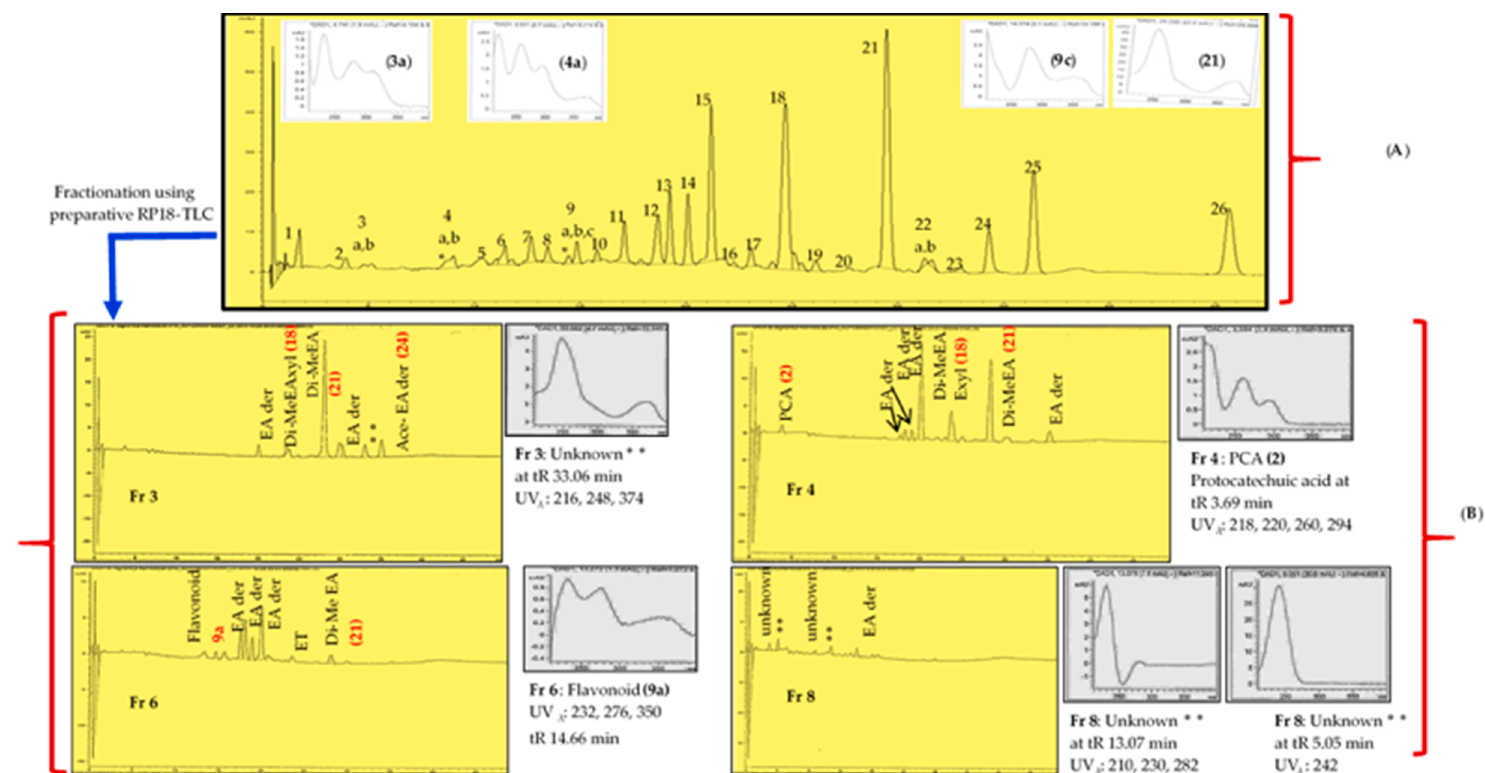
Figure 5. ( A ) Methanolic Soxhlet extract of the root of A. leiocarpa . ( 1 ) Gallic acid, ( 2 ) protocatechuic acid, ( 3a ) flavonoid, ( 3b ) alkaloid, ( 4a ) flavonoid, ( 4b ) ellagitannin, ( 5 ) aromadendrin, ( 6 ) di-galloyl- β -D-glucose, ( 7 ) ampelopsin, ( 8 ) methyltaxifolin, ( 9a *) flavonoid, ( 9b ) isomer of methyltaxifolin, ( 9c ) flavonoid, (10) ellagic acid derivatives, ( 11 ) taxifolin, ( 12 ) ellagic acid derivatives, ( 13 ) ellagic acid derivatives, ( 14 ) ellagic acid derivative, ( 15 ) di-methyl ellagic acid glucoside, ( 16 ) pentagalloylglucose, ( 17 ) ellagic acid derivatives, ( 18 ) di-methyl ellagic acid xylopyranoside, ( 19 ) ellagitannin, ( 20 ) ellagitannins, ( 21 ) di-methyl ellagic acid, ( 22a ) ellagitannin, ( 22b ) ellagitannin, ( 23 ) pinosylvin, ( 24 ) acetylated ellagic acid derivative, ( 25 ) ellagic acid derivatives, and ( 26 ) methylpinosylvin. ( B ) TLC chromatograms of RP 18 TLC fractions ( Fr3 – Fr8 ) obtained from the methanol Soxhlet extract ( A ); ** Unknown compounds; (EA der), ellagic acid derivatives; (Di-Me EA xyl), dimethyl ellagic acid xyloside; (ET), ellagitannin; (Ace-EA der), acetylated ellagic acid derivatives; and (PCA), protocatechuic acid. Main compounds with bold text.